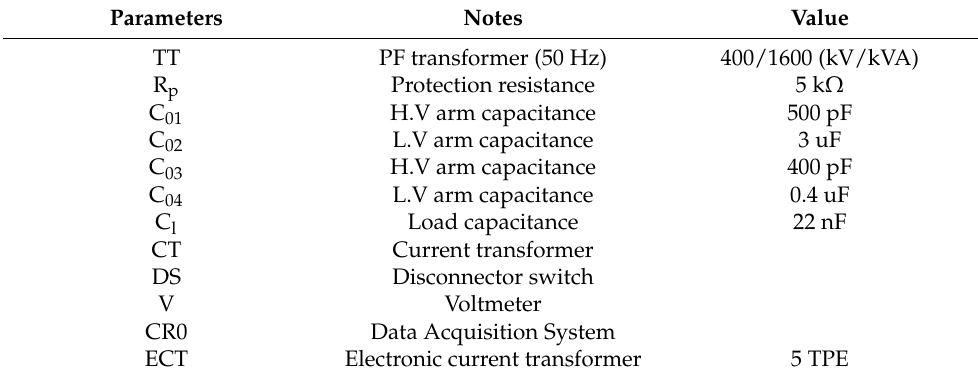
Table 1. Main parameters of power frequency voltage measurement system.